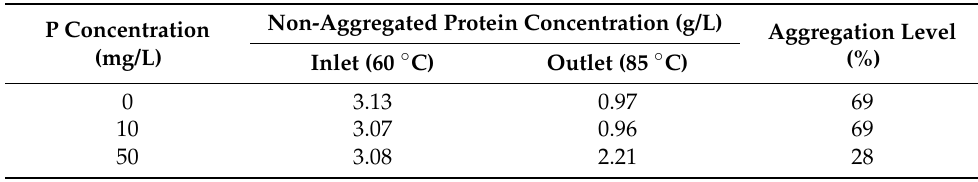
Table 2. Measured initial (inlet of the PHE) and final (outlet of the PHE) soluble β -lg (non-aggregated)